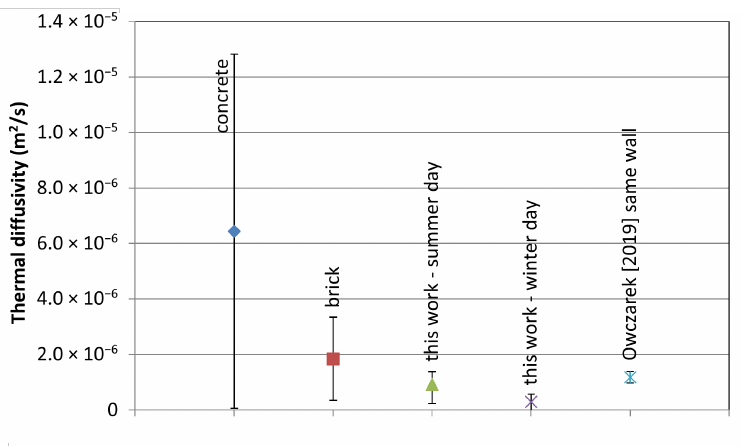
Figure 9. Ranges of measured values of thermal diffusivity from the literature and the authors’ measure-